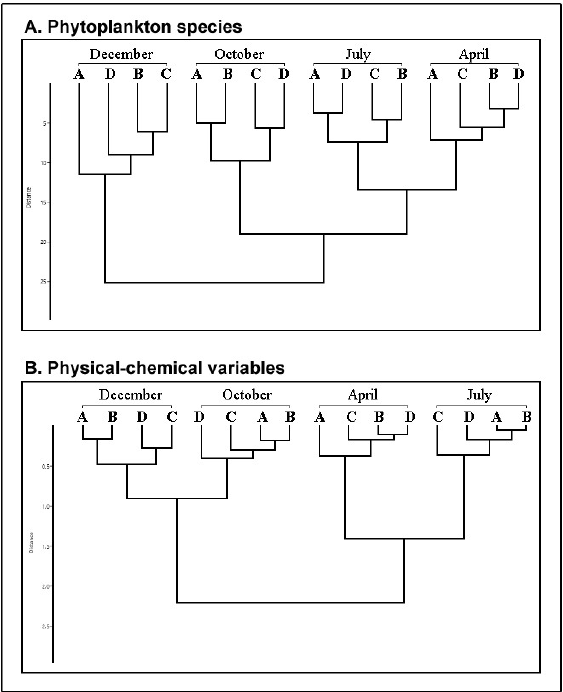
Figure 7. Hierarchical cluster analysis was performed on the algal composition ( A ) and physical- chemical variables ( B ) during the four investigated seasons. Zone A represents the upstream river area affected by agricultural activities, zone B represents the forest and agricultural area, zone C represents the urban area, and zone D represents the downstream river area affected by agricultural and livestock